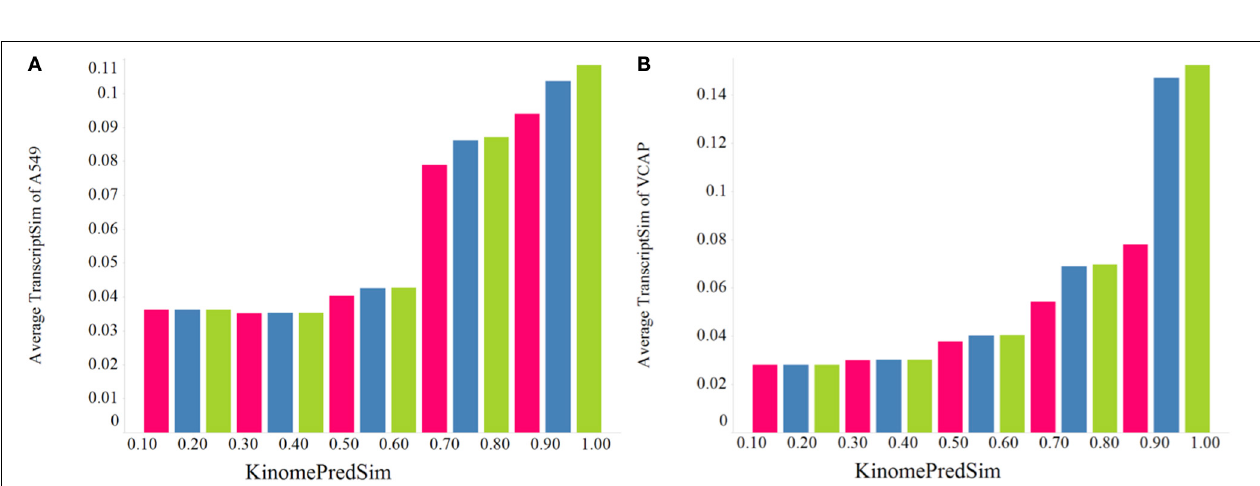
applied are: 1.0 (green) including all compound pairs, 0.8 (blue) removing compound pairs more similar than 0.8, and 0.5 (red) leaving only dissimilar compound pairs (ChemSim < 0.5).